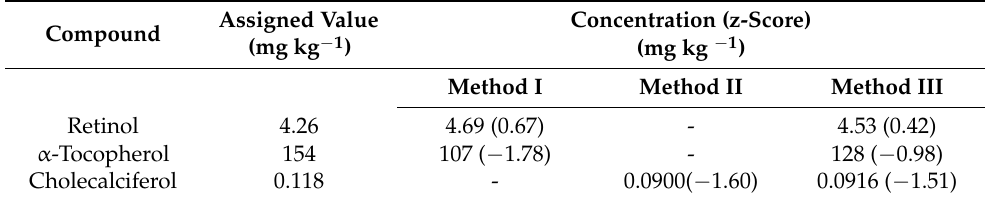
Table 11. Results of the determination of vitamins in a baby milk proficiency test. Compound